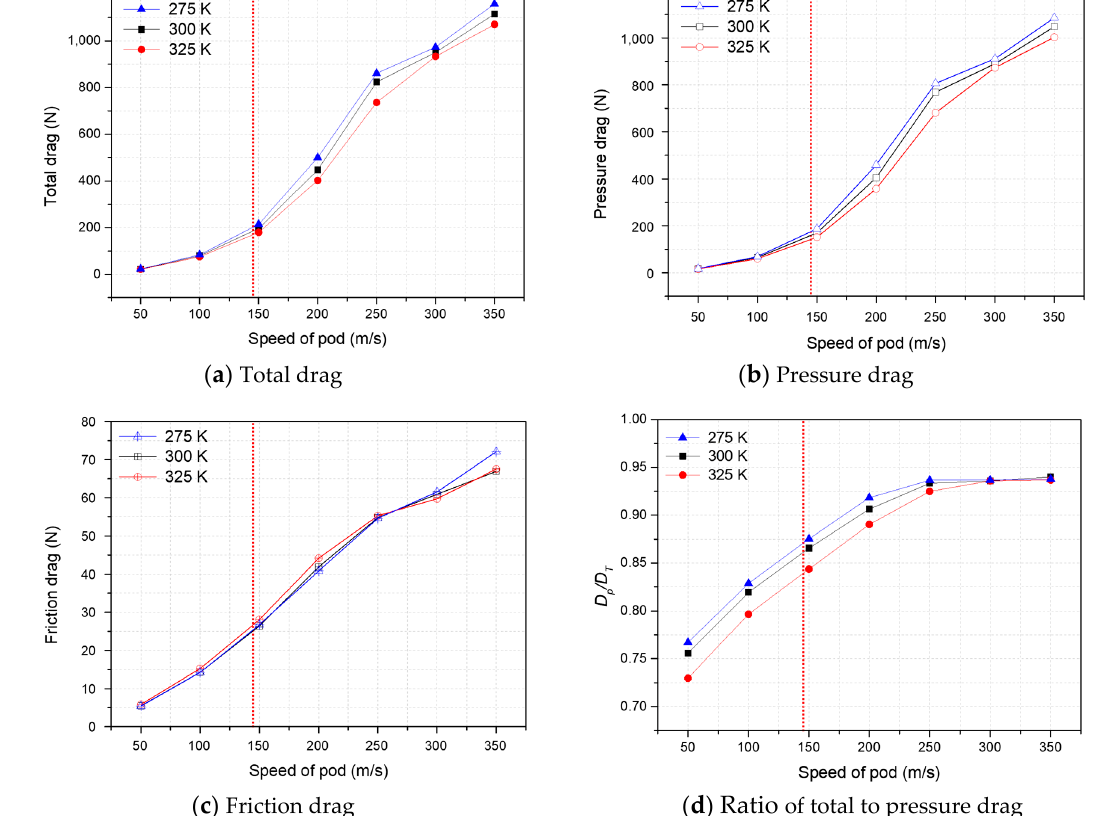
Figure 12. Effects of tube temperature on drag.